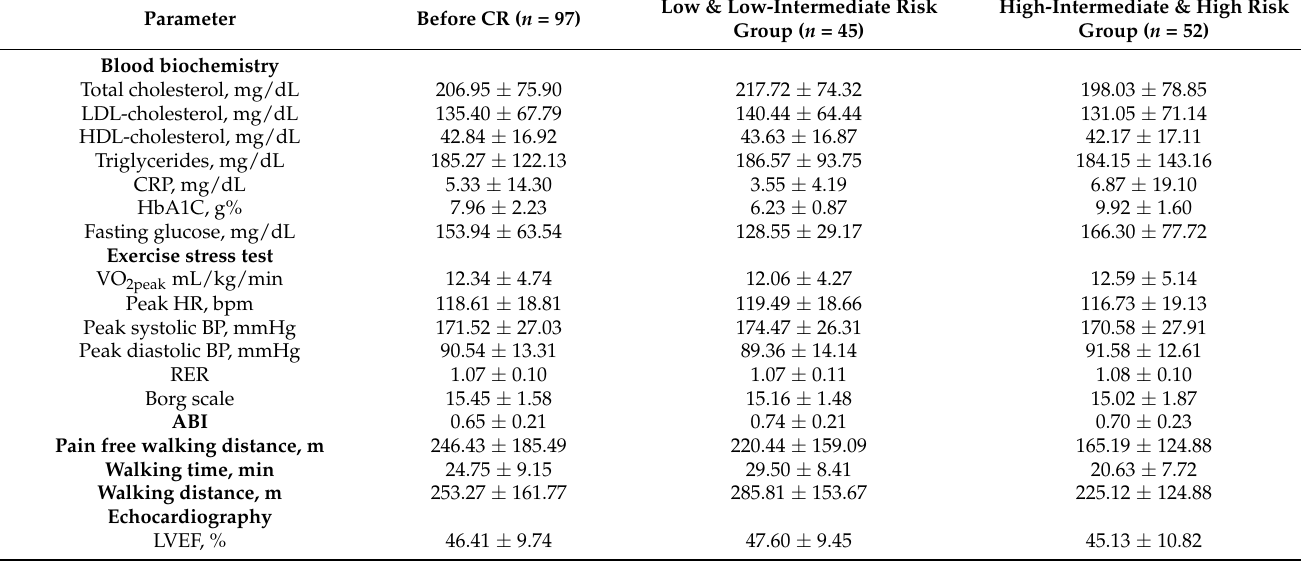
Table 4. Blood biochemistry and exercise stress test parameters before CR.